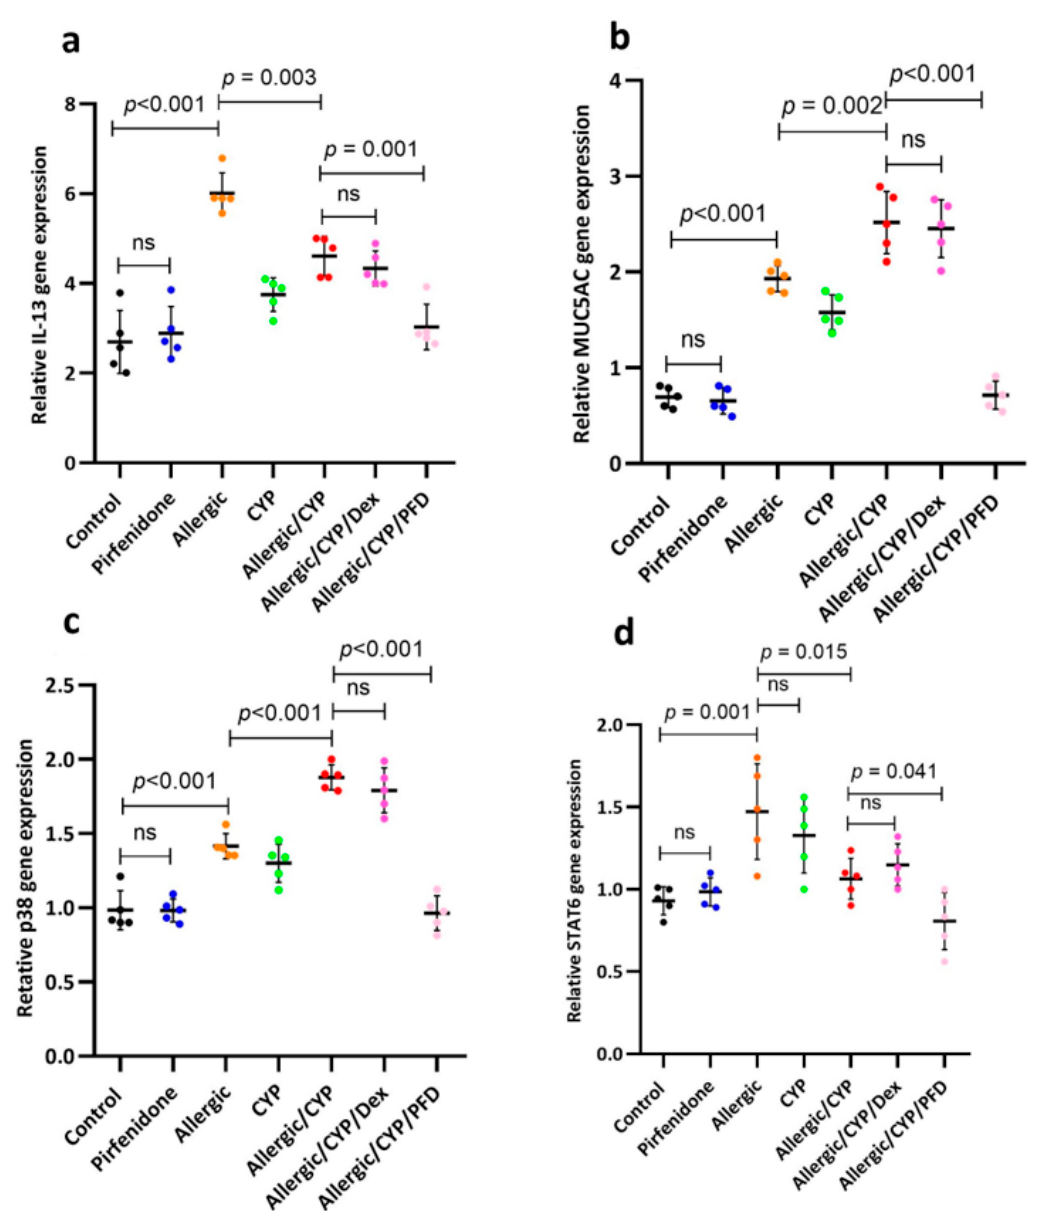
Figure 2. The effect of pirfenidone on the gene expression profile of IL-13 ( a ), MUC5AC ( b ), p38 ( c ), and STAT6 ( d ) genes determined by PCR in the CYP-exposed allergic rats at the end of the experi- ment. The data are shown as mean ± SD, n = 5 lung tissue samples. Horizontal lines indicate the statistical significance and the p -value between groups using one-way ANOVA (Tukey’s post hoc test). ns: nonsignificant.